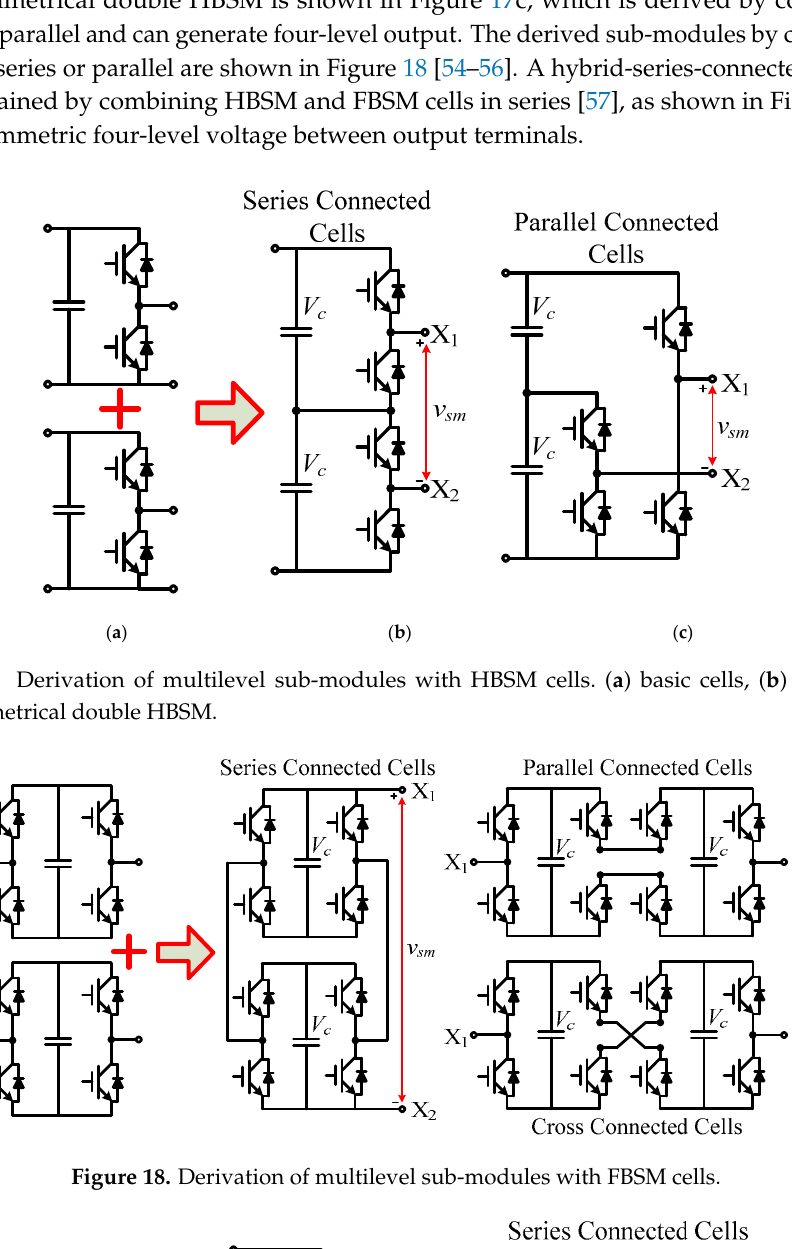
Figure 18. Derivation of multilevel sub-modules with FBSM cells.